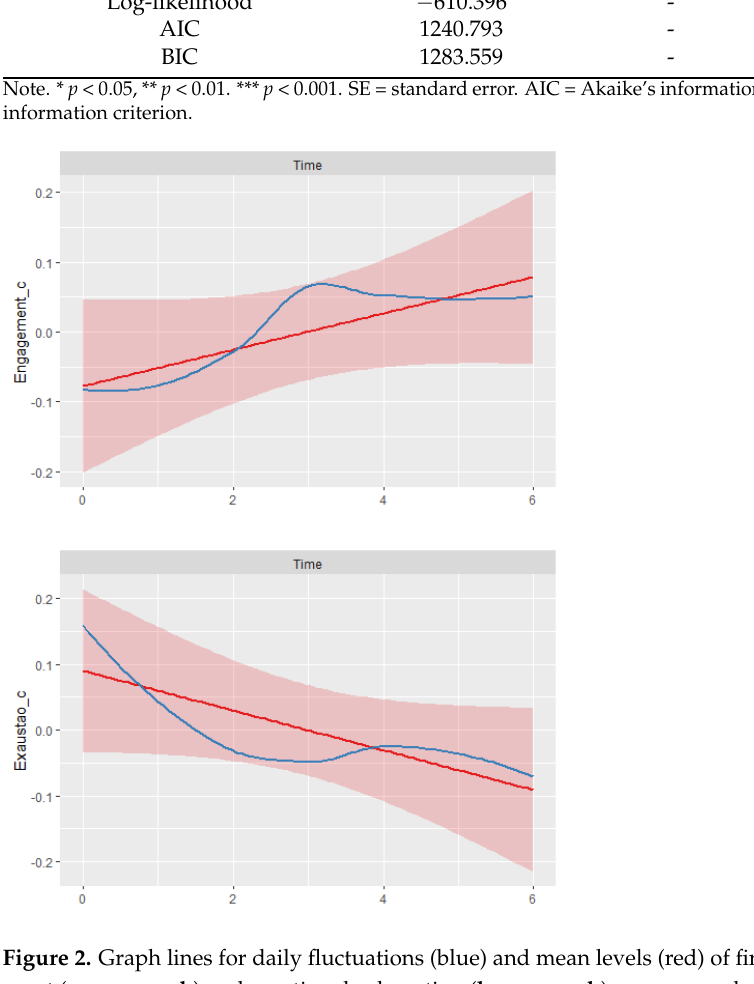
Figure 2. Graph lines for daily fluctuations (blue) and mean levels (red) of firefighters’ work engage- ment ( upper graph ) and emotional exhaustion ( lower graph ) over seven